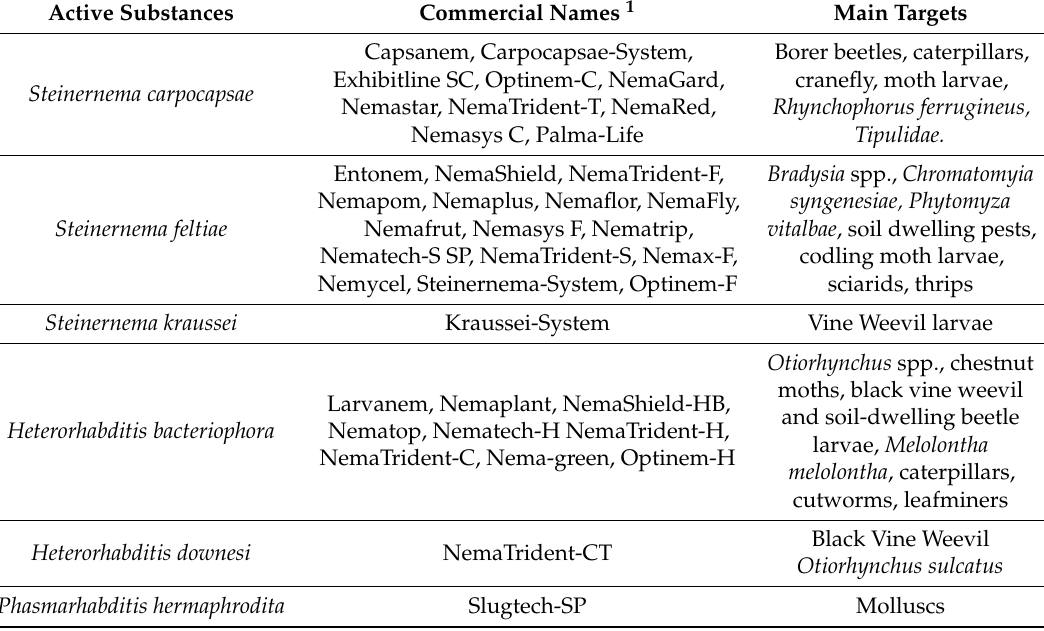
Table 4. Selection of commercial products based on entomopathogenic nematodes